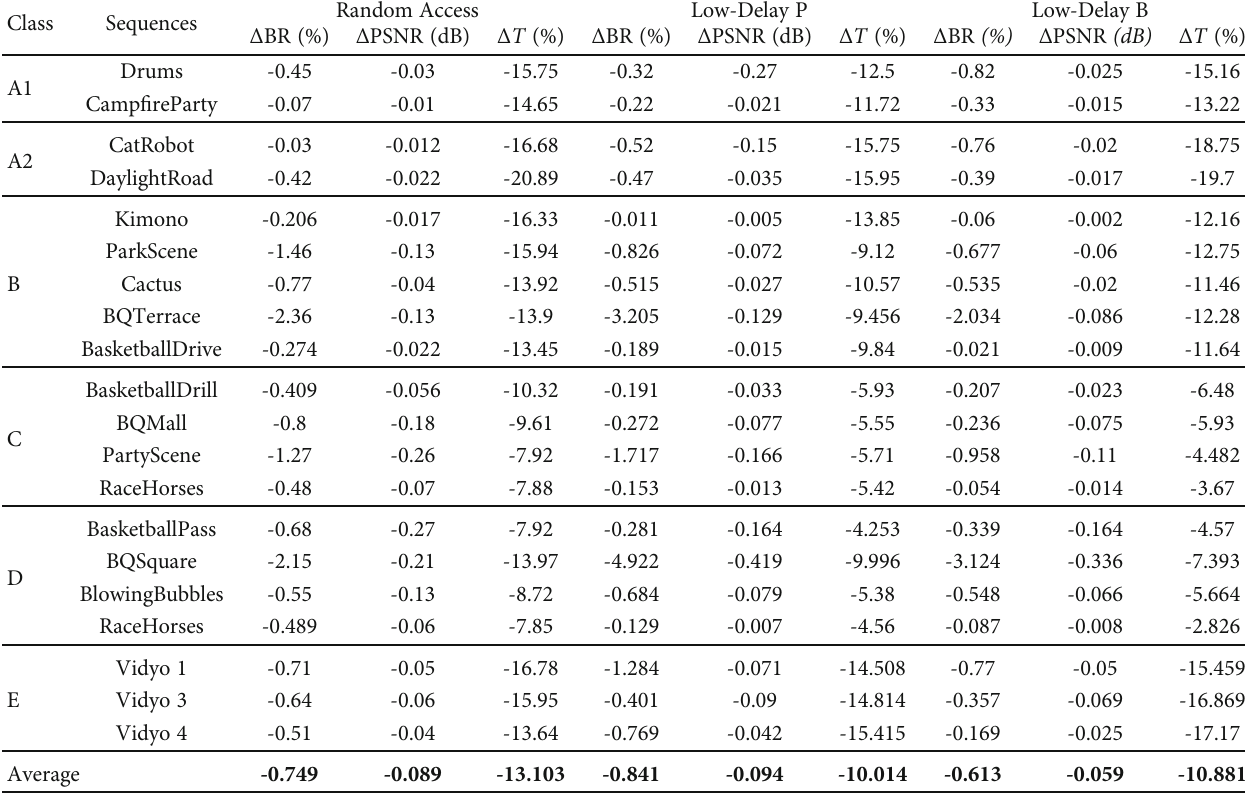
Table 2: Results achieved from the proposed scheme versus the original FVC